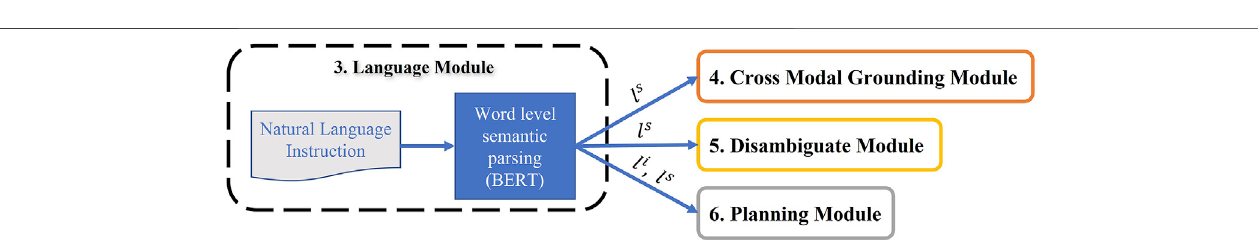
FIGURE 7 | Language Module: The extracted intent and slot- fi lling from the fi ne-tuned Bert model is used in Cross-Modal grounding, Disambiguate and Planning modules.